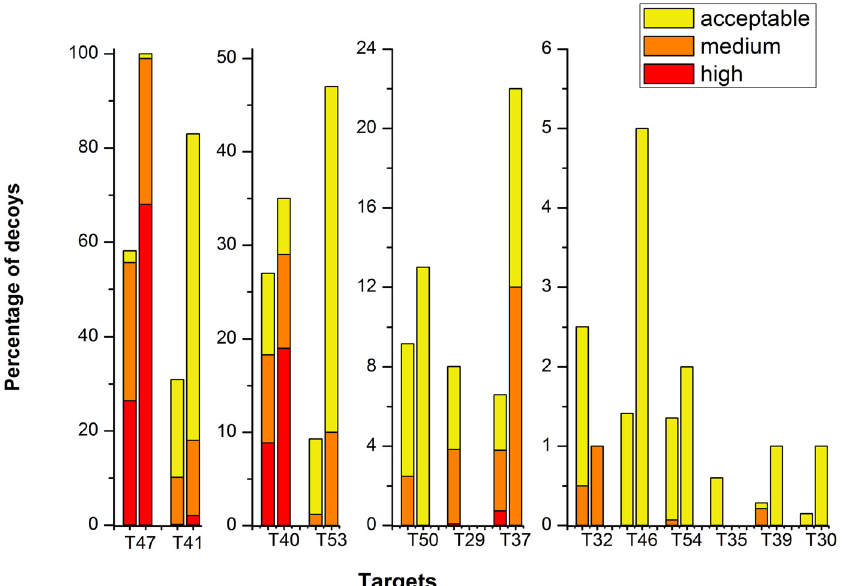
Fig 3. Enrichment of acceptable or better structures. For each of the 13 targets with acceptable or better decoys, two columns (from left to right) show the CAPRI Score_set and the top 100 in our rank of binding free energy calculation. Red, orange and yellow represent the fractions of high, medium and acceptable quality structures, respectively, of the number of the selected docking decoys. The ordering of the targets is based on the fraction of acceptable or better structures in each target; easy targets with a high fraction are on the left, hard targets with low fraction on the right. Note that for improved readability, the vertical scale decreases from left to